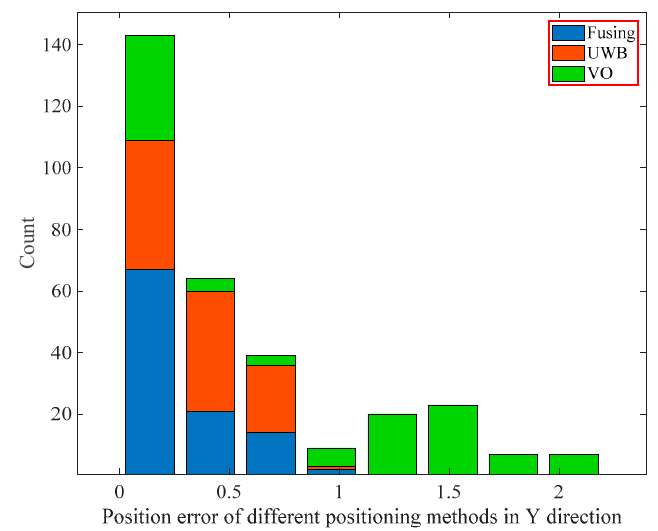
Figure 14. Position error distribution histogram in the Y direction. Table 2. Percentage of location points in the x direction.